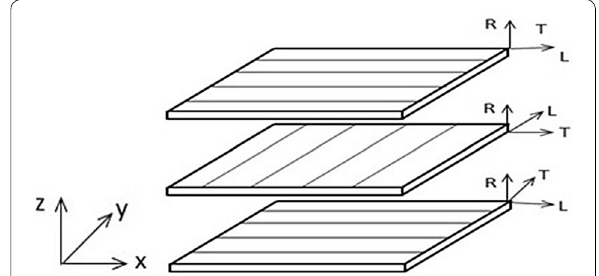
Fig. 6 Configuration of plywood